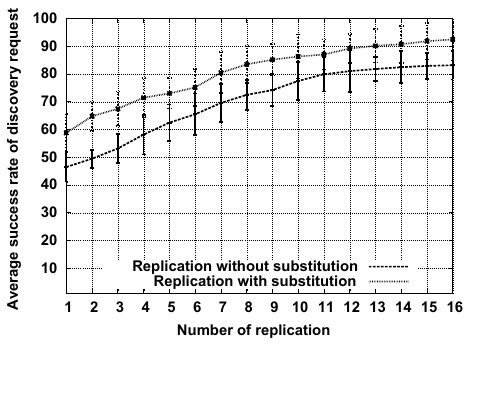
Figure 14. Success rate evaluation in the lookup